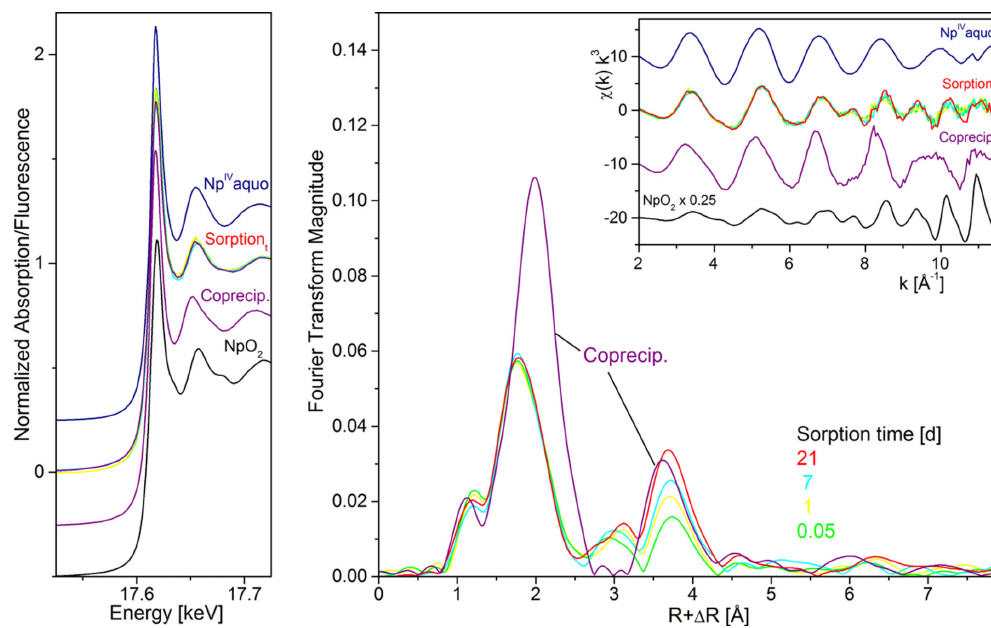
Figure 5. Neptunium L 3 –edge XAFS spectra of selected siderite sorption and coprecipitation samples (pH7.7 ± 0.3) along with Np references. Left: XANES spectra, right: EXAFS Fourier transform magnitude and corresponding χ (k) spectra as insert . Reprinted with permission from ref. [33]. Copyright 2021 Amrican Chemical Society.